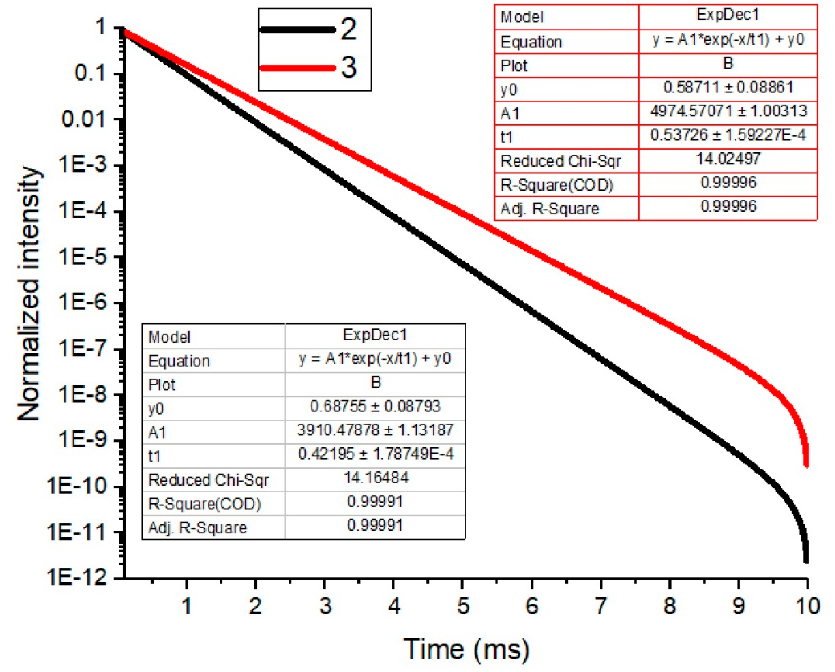
Figure 12. 5 D 0 → 7 F 2 level decay time profile at 393 nm of complex 2 : [Eu(OOCC 6 H 5 ) 3 · (H 2 O) 3 ] and complex 3 : [Eu(OOCC 6 H 5 ) 3 · (HOOCC 6 H 5 ) 2 ].